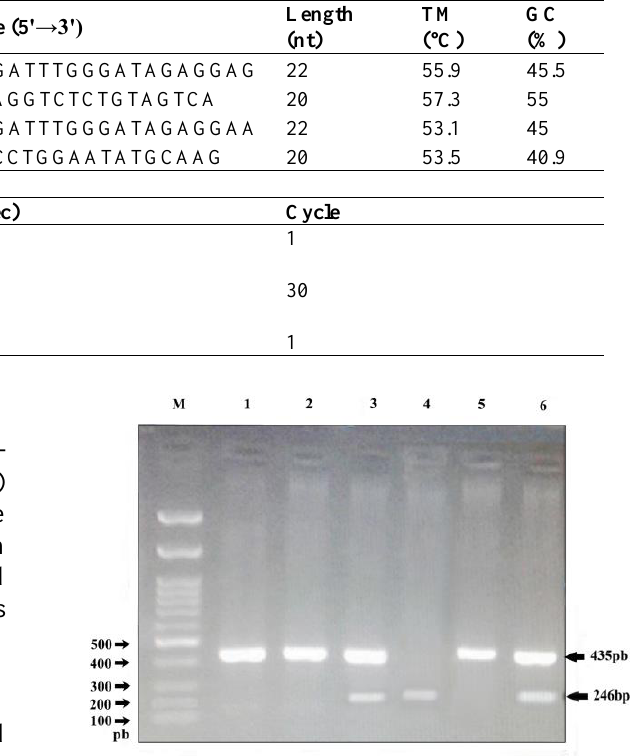
Fig. 1. Genotyping of the rs1800460 SNP using AS- PCR. Presence of a single 246 bp band as homozygous wild type genotype, a single 435 bp band as homozygous mutant genotype, two bands of 246 and 435 bp as heterozygote genotype. Lane M;100 bp DNA ladder, 1-6 amplified DNA